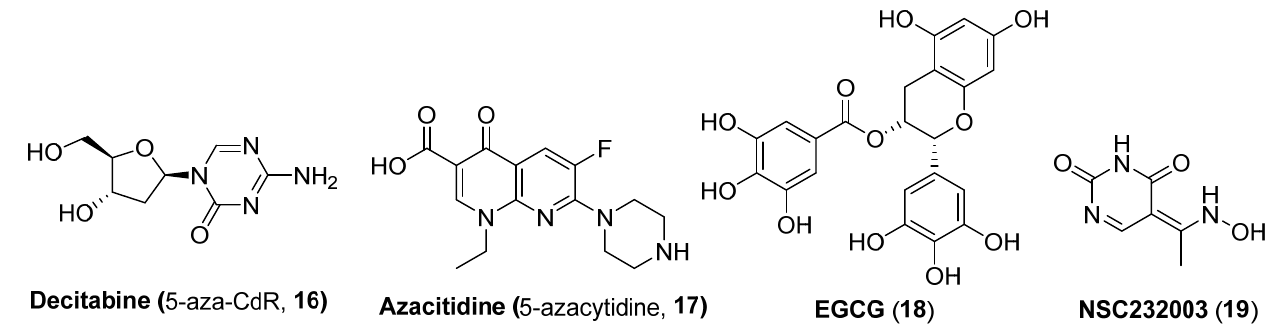
Figure 5. Chemical structures of DMTIs (16 and 17) and UHRF1s (18 and 19) with latency-reversal